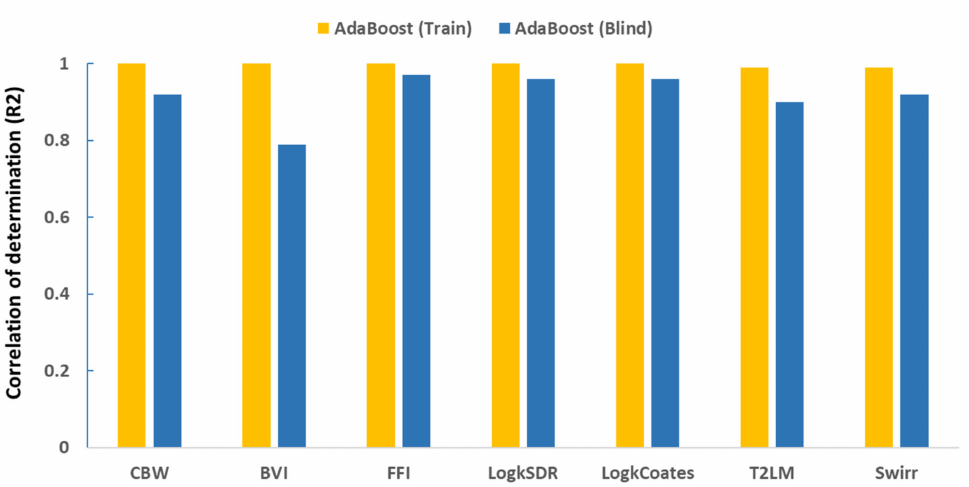
Figure 9. A comparison of the Adaboost’s performance for the training and blind datasets in predicting NMR log